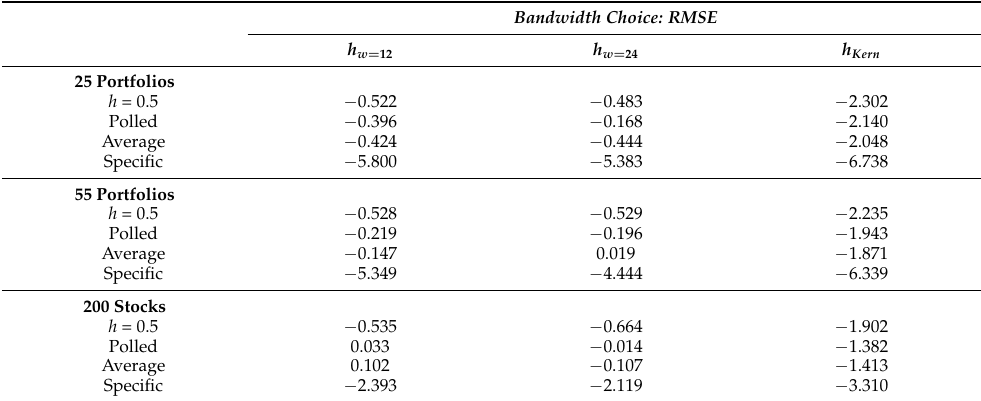
Table 5. Percentage reduction of RMSE in respect to the benchmark model. Bandwidth Choice: RMSE h w = 12 h w = 24 h Kern 25 Portfolios h =